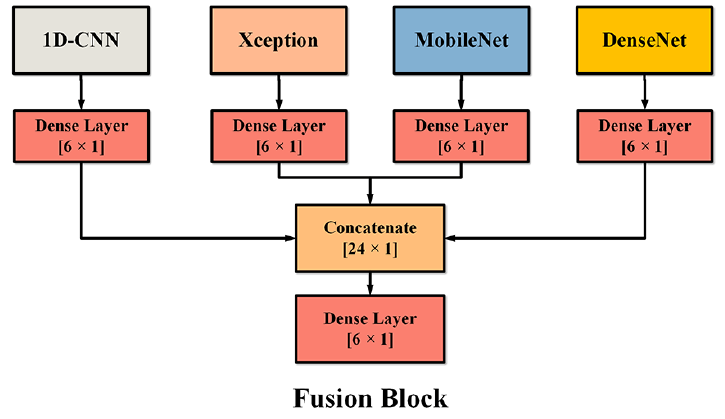
Figure 5. The fusion block of MDF-PNet at the connection layer.